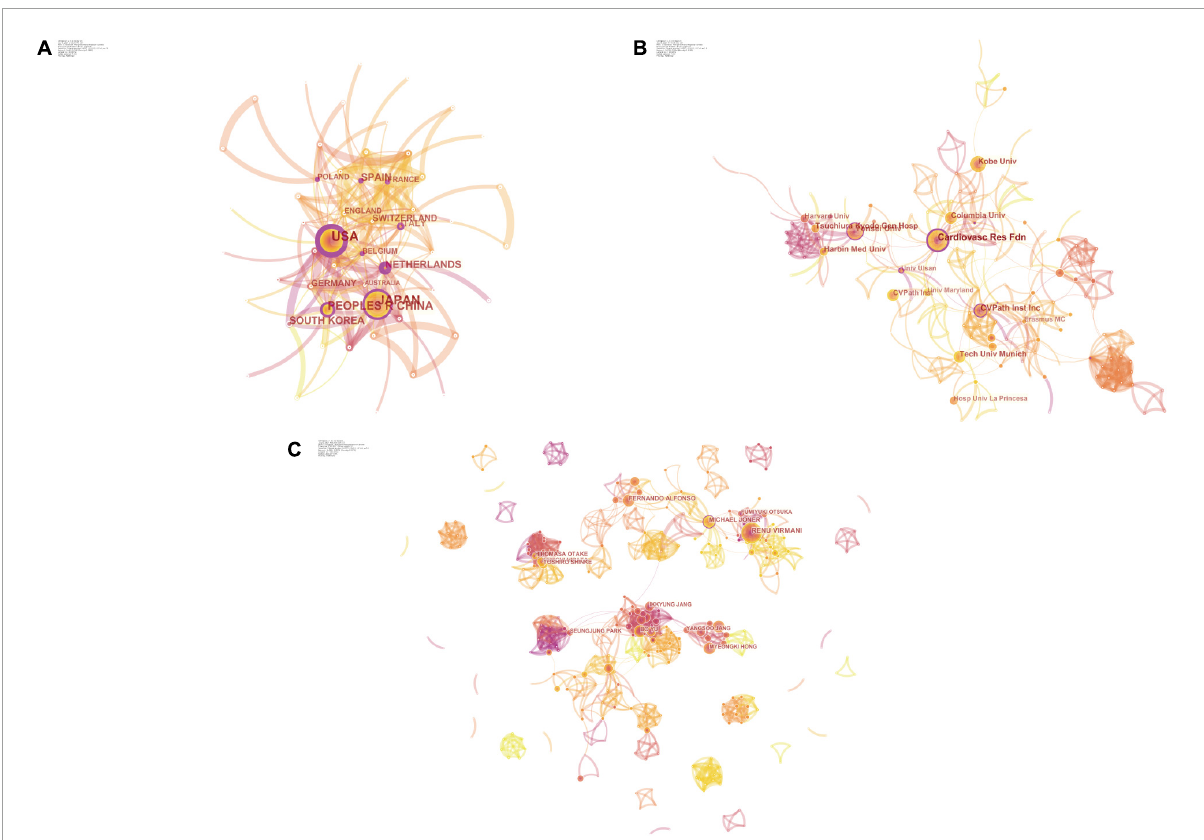
FIGURE3 The collaboration analysis of countries/regions, institutions, and scholars in the field of ISNA. The size of the nodes represents the number of posts; the connection between the nodes represents the cooperation; the thickness of the connection represents the strength of the cooperation. Betweenness centrality is a measure of the importance of nodes in the network (in addition to degree centrality, proximity centrality, etc.), and such nodes play the role of "bridges" in the network and are highlighted with purple circles. (A) The collaboration network of countries/regions. (B) The collaboration network of institutions. (C) The collaboration network of